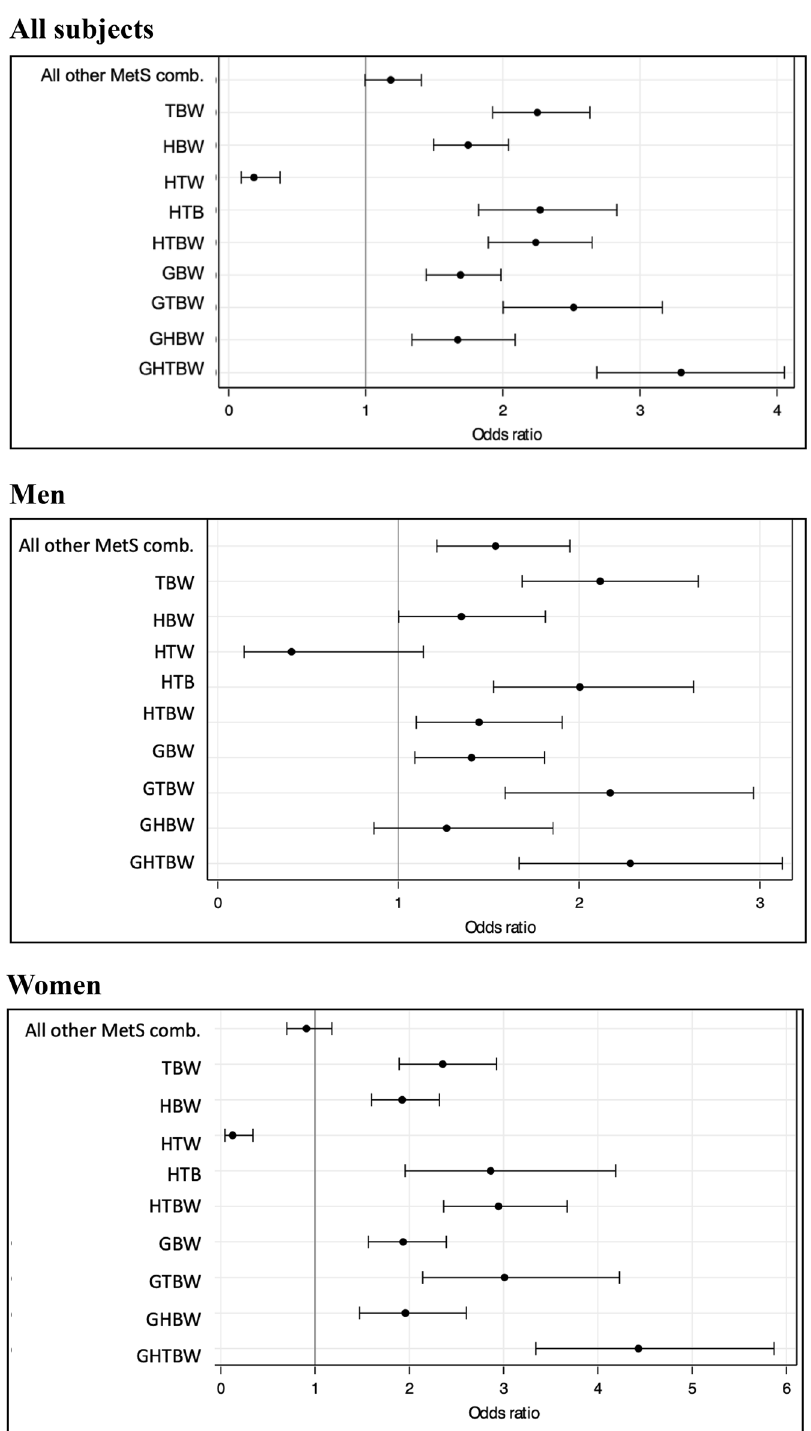
Figure 2. Clusters of MetS components as determinants of high CSBP—controlling for age, diabetes mellitus, nonHDL-C, and mean blood pressure. Odds ratio (OR) with 95% confidence interval for specific MetS clusters of components in the whole population (upper panel), in men (central panel), and women (lower panel). We evaluated all the possible combinations of MetS components, but only specific clusters are described here. Abbreviations: All other MetS comb., all different combinations of metabolic syndrome components not depicted in the picture; MetS, metabolic syndrome; W, abdominal obesity; H, low HDL cholesterol; B, high blood pressure; T, triglycerides; G, glucose; MAP, mean arterial pressure. Not significant clusters in men: HTW, HBW, GHBW ; in women: HTW ; in the whole population: HTW